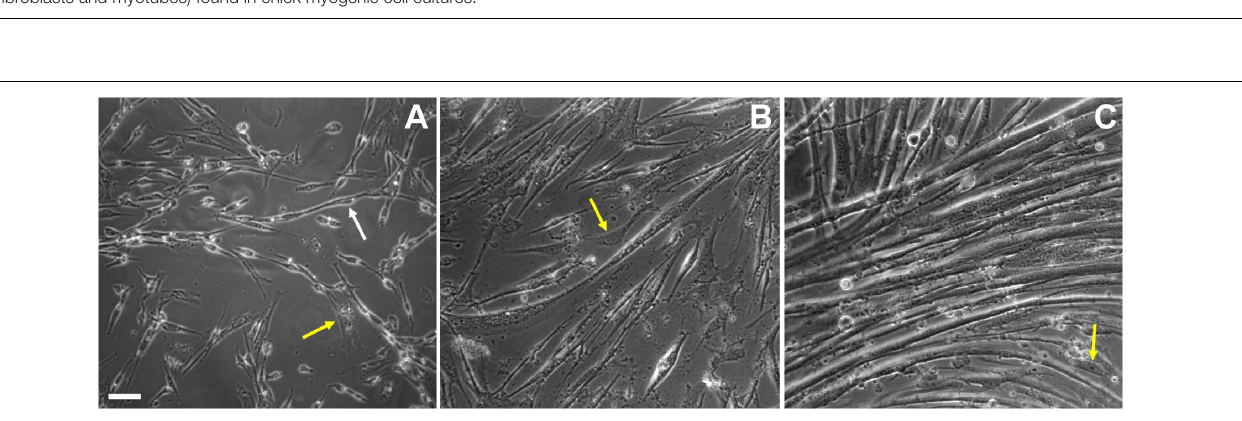
Frontiers in Physiology |